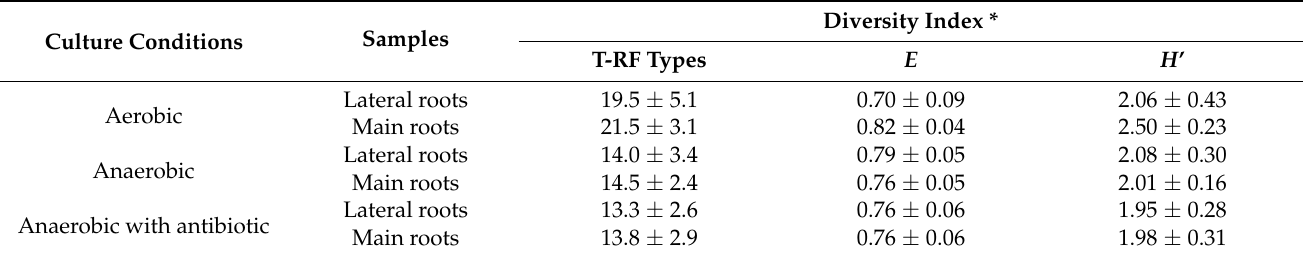
Table 3. Diversity indices of culturable bacterial T-RFs in each culture conditions. Culture Conditions